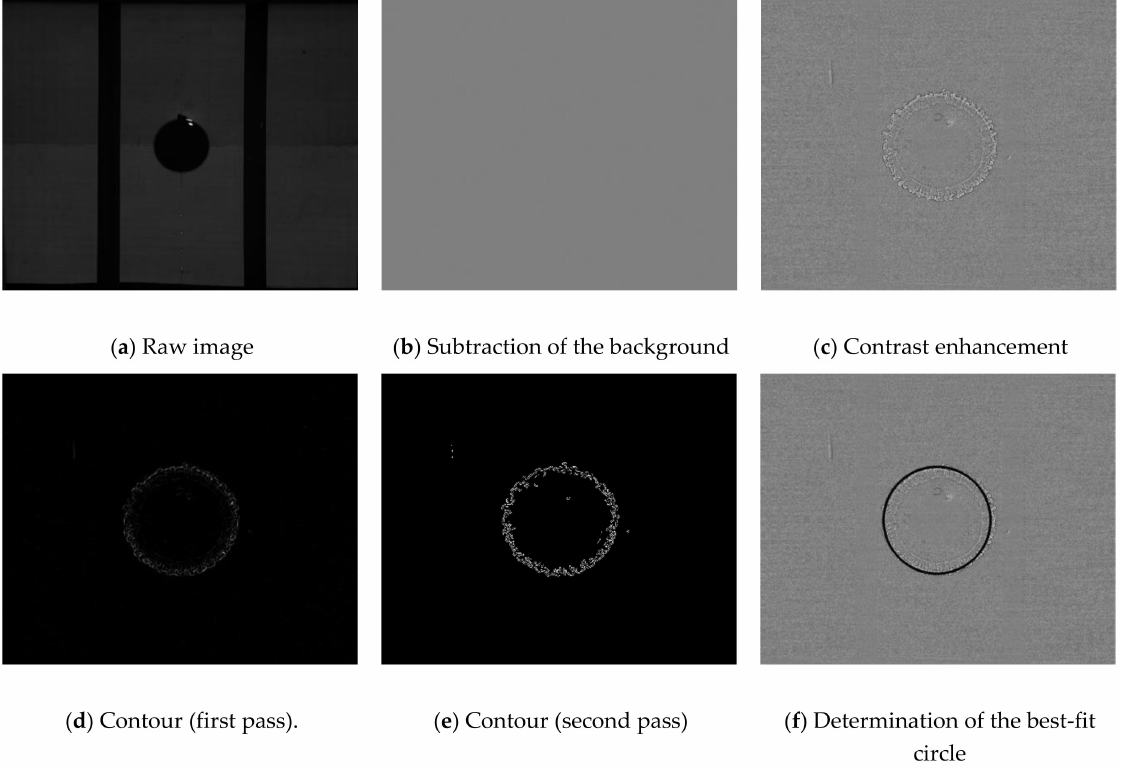
Figure 4. Processing steps for the top-view